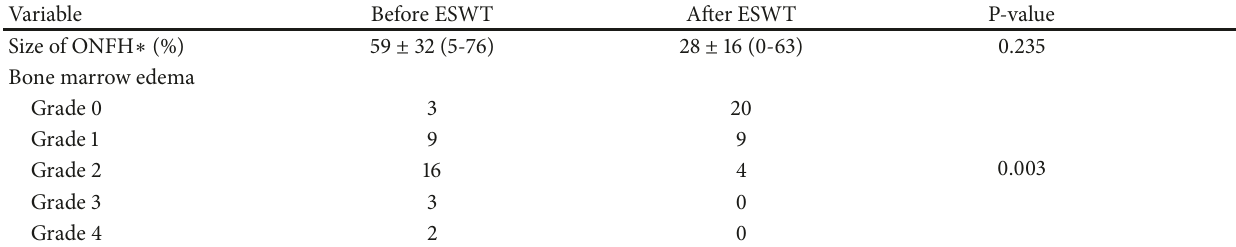
Table 4: Changes on plain radiographs and MRI images before and after ESWT.